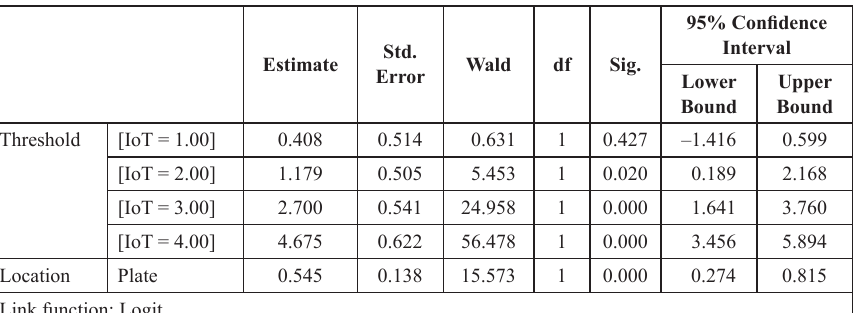
Table 4. The parameter estimates for students